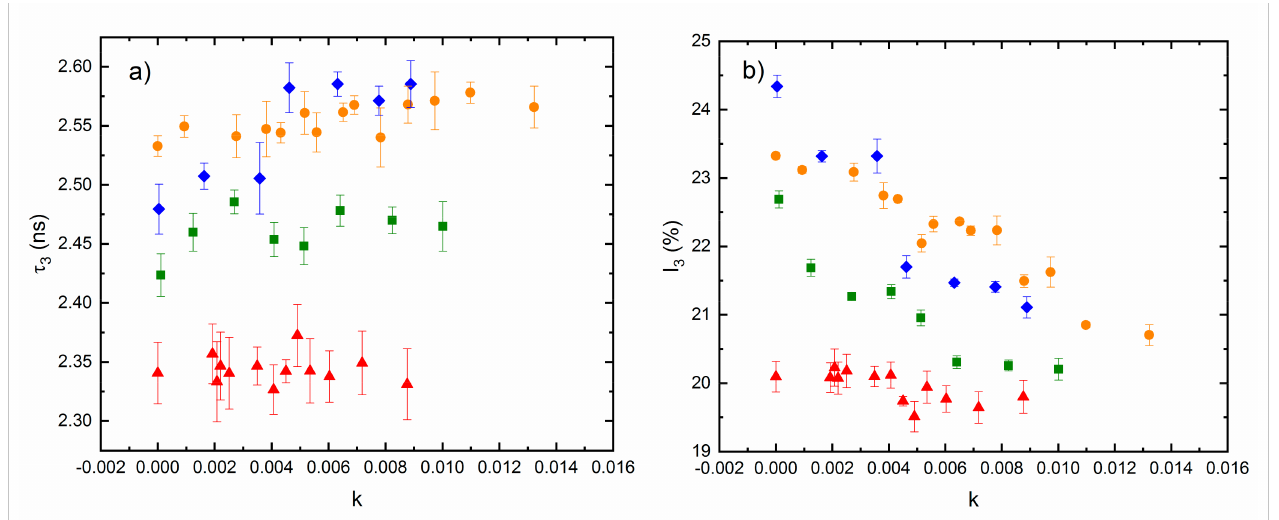
Figure 10. The o-Ps lifetime ( a ) and their relative intensity I 3 ( b ) as a function of water content expressed by k for the investigated samples. AESO/VDM squares, AESO/VDM/DMPA triangles, ELO/PI dots, and ELO/10RD1/PI